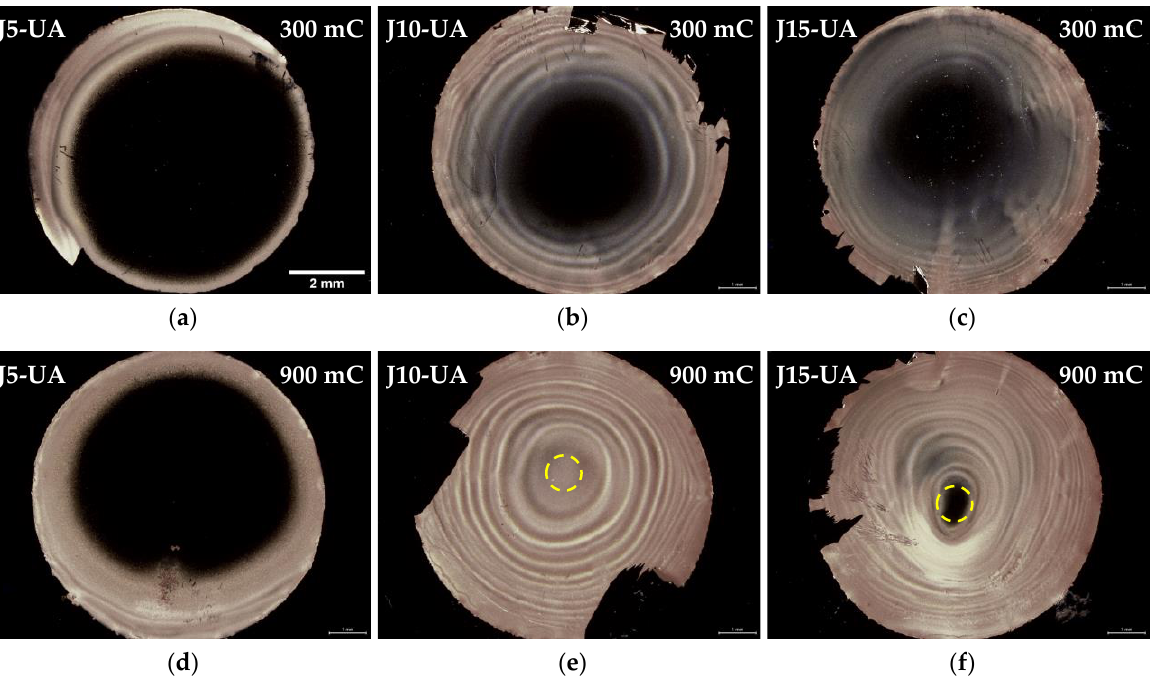
Figure 6. Digital microscopy images of the as deposited Cu films at 5 ( a ), 10 ( b ), and 15 mA·cm −2 ( c ) for 300 mC and the same current densities ( d ), ( e ), and ( f ), respectively, for 900 mC, under ultrasonic electrolyte agitation.